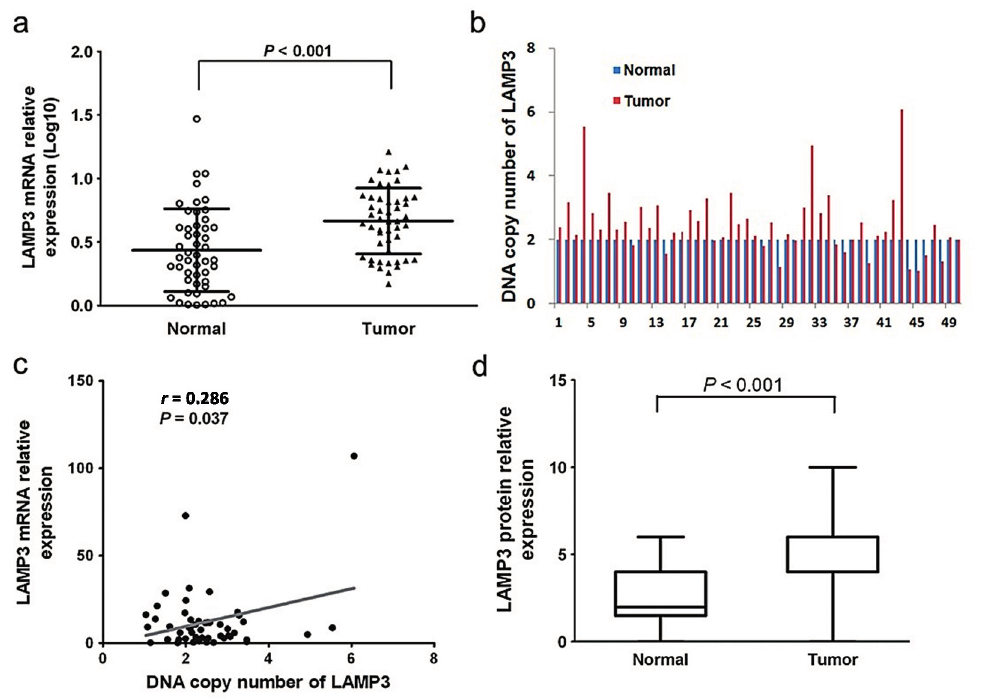
Figure 1. The expression level and DNA copy number of LAMP3 in ESCC tissues and adjacent normal controls. ( a ) LAMP3 mRNA expression level in 50 paired cancerous and normal tissues was detected by qRT-PCR. Triangles, the ESCC tumor tissue samples; circles, the adjacent normal tissue samples; ( b ) DNA copy number of LAMP3 in 50 paired cancerous and normal tissues was detected by qRT-PCR; ( c ) The correlation between LAMP3 DNA copy number and its transcriptional expression level in tumor tissues ( n = 50); ( d ) LAMP3 protein expression level in 46 paired cancerous and normal tissues was detected by